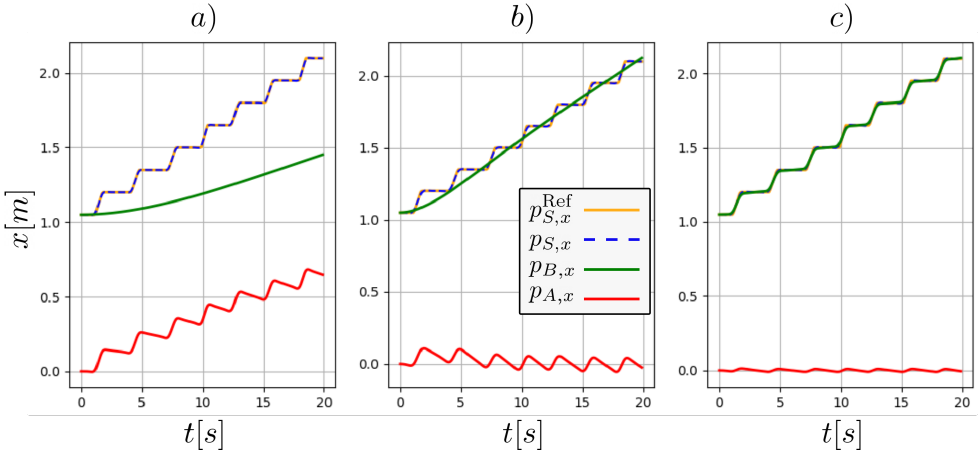
Figure 5. Solutions to the MPC optimization problem in the x direction using different criterion function parameters. Parameters are given in Table 1. Spray frame trajectory p S , x is a sum of p A , x and p B , x . Table 1. MPC criterion function parameters resulting in trajectories shown in Figure